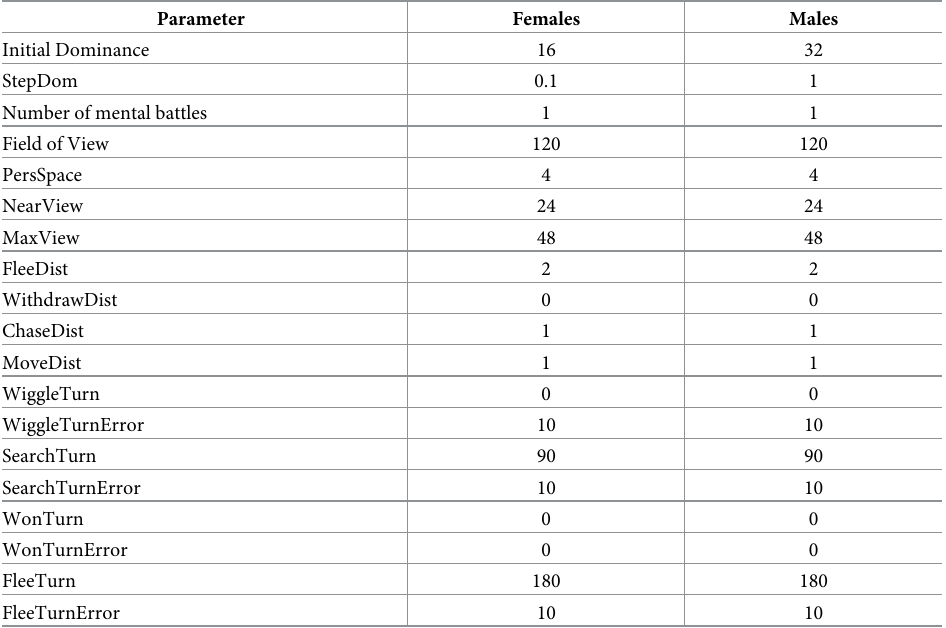
Table 1. Parameters for DomWorld for females and males. Parameter Females Males Initial Dominance 16 32 StepDom 0.1 1 Number of mental battles 1 1 Field of View 120 120 PersSpace 4 4 NearView 24 24 MaxView 48 48 FleeDist 2 2 WithdrawDist 0 0 ChaseDist 1 1 MoveDist 1 1 WiggleTurn 0 0 WiggleTurnError 10 10 SearchTurn 90 90 SearchTurnError 10 10 WonTurn 0 0 WonTurnError 0 0 FleeTurn 180 180 FleeTurnError 10 10 Field of View indicates the viewangle with which individuals see others, MoveDist indicates step size, WiggleTurn and WiggleTurnError indicate small random turn during forward motion. Individuals turn after searching for others (SearchTurn with SearchTurnError), after winning a fight (WonTurn with WonTurnError) and after fleeing (FleeTurn with FleeTurnError), for the other parameters see main text and Hemelrijk [12, 48].